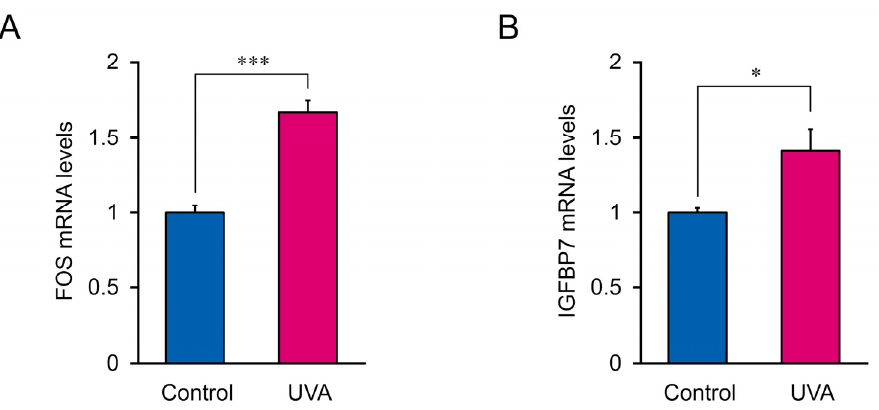
Figure 7. IGFBP7 and Fos mRNA expression in cells treated with 5 J/cm 2 UVA radiation. ( A ) Fos mRNA levels. ( B ) IGFBP7 mRNA levels. Data represent the mean ± SEM of three biological independent experiments performed in triplicate. Asterisks indicate significant difference analyzed using Student’s t -test, * p < 0.05, *** p < 0.001 vs. control, UVA non-irradiation group.